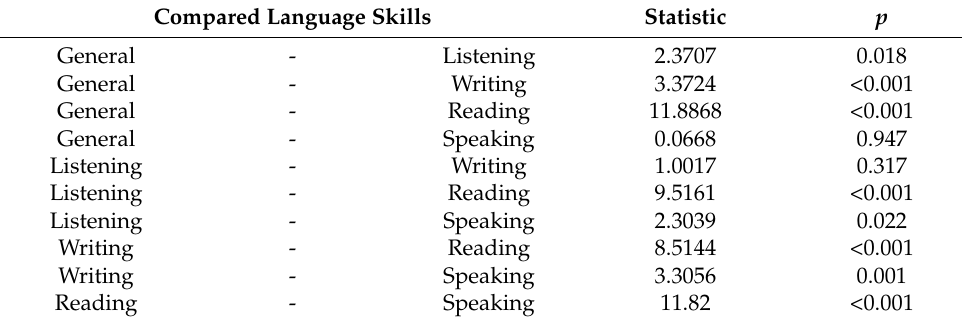
Table 4. Pairwise Comparisons